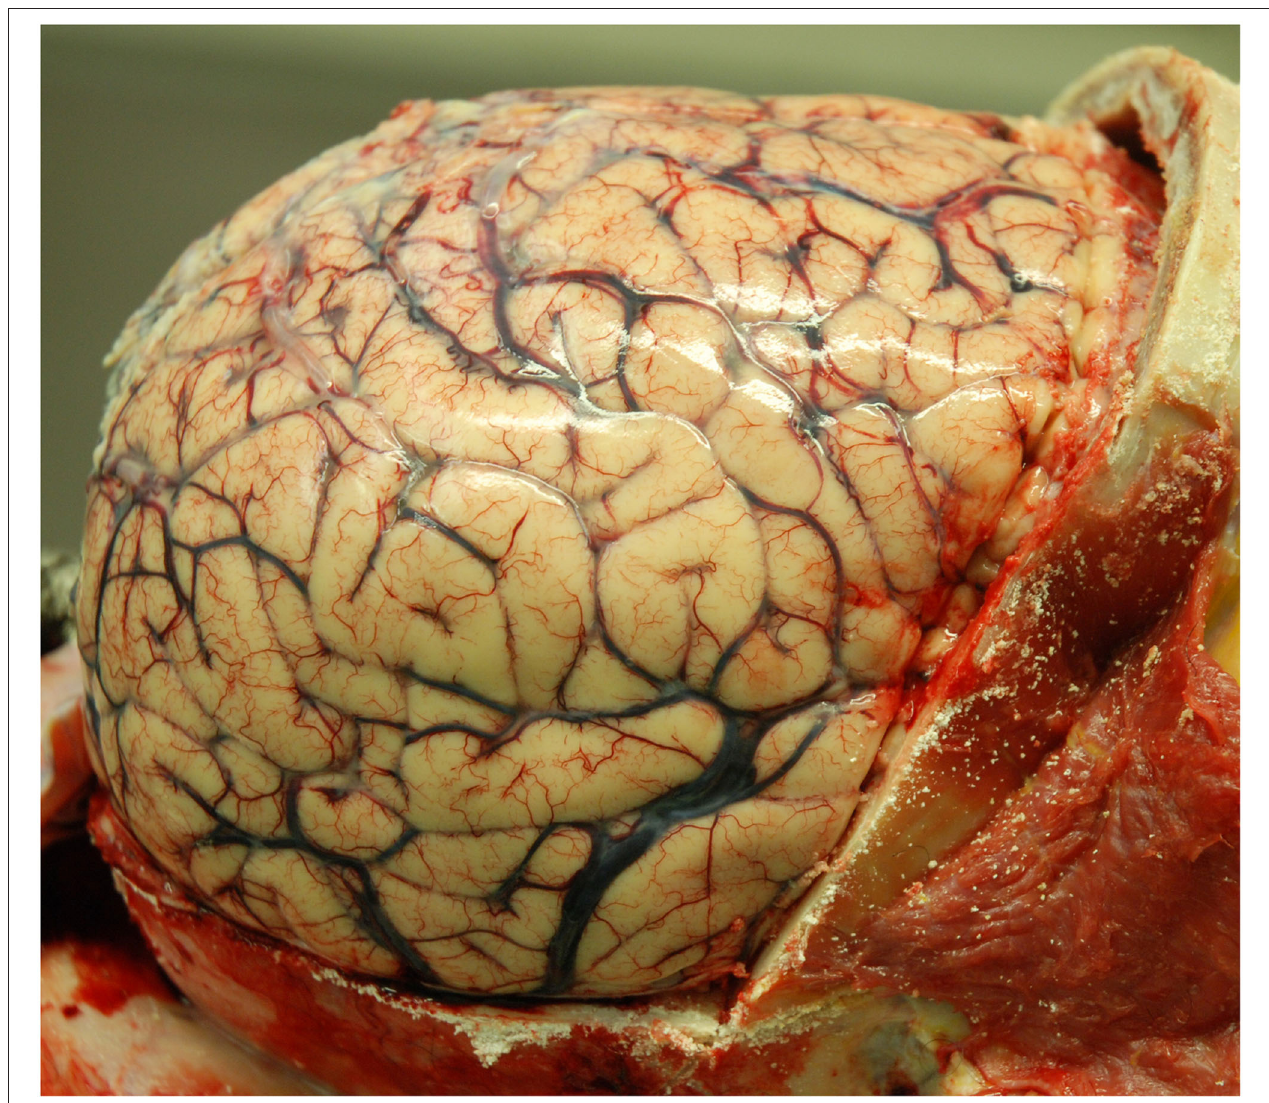
FIGURE 4 | Case 10. Uniformly swollen brain in a patient with HIV-CD8E (gyral flattening and swelling) after removal of the skull bone [(2), reproduced with